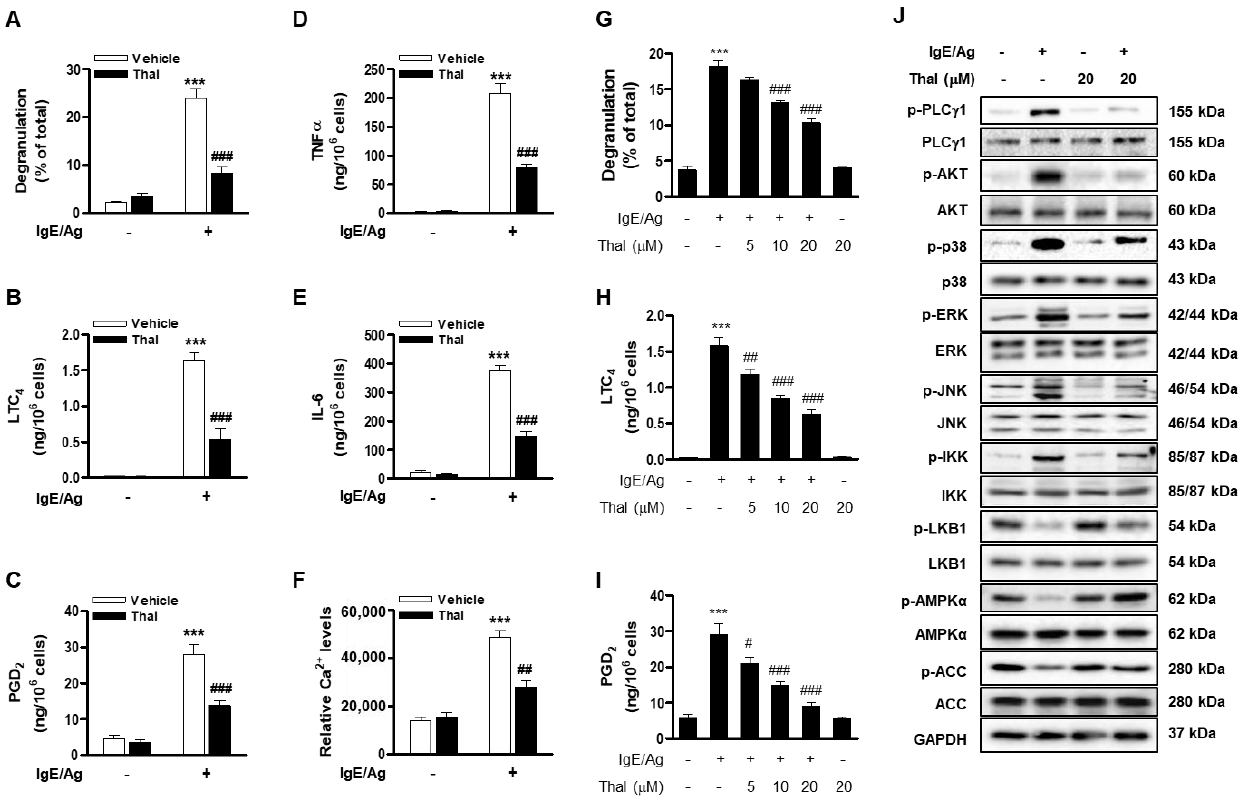
Figure 1. Thalidomide attenuates Fc ε RI-mediated mast cell activation. BMMCs were sensitized with anti-DNP IgE and treated with 20 µ M of thalidomide (Thal) ( A – F , J ) or different concentrations of thalidomide ( G – I ) for 1 h followed by stimulation with DNP-HSA (Ag). Degranulation ( A , G ) and secretion of LTC 4 ( B , H ), PGD 2 ( C , I ), TNF α ( D ), and IL-6 ( E ), and the level of intracellular Ca 2+ ( F ), were evaluated. Cell lysates were subjected to immunoblotting with the indicated antibodies ( J ). Data ( A – I ) represent the means ± SEM from at least three independent experiments with different BMMCs ( *** p < 0.01 vs. control; # p < 0.05, ## p < 0.01 and ### p < 0.001 vs. IgE/Ag alone), and the immunoblots ( J ) are representative of three independent